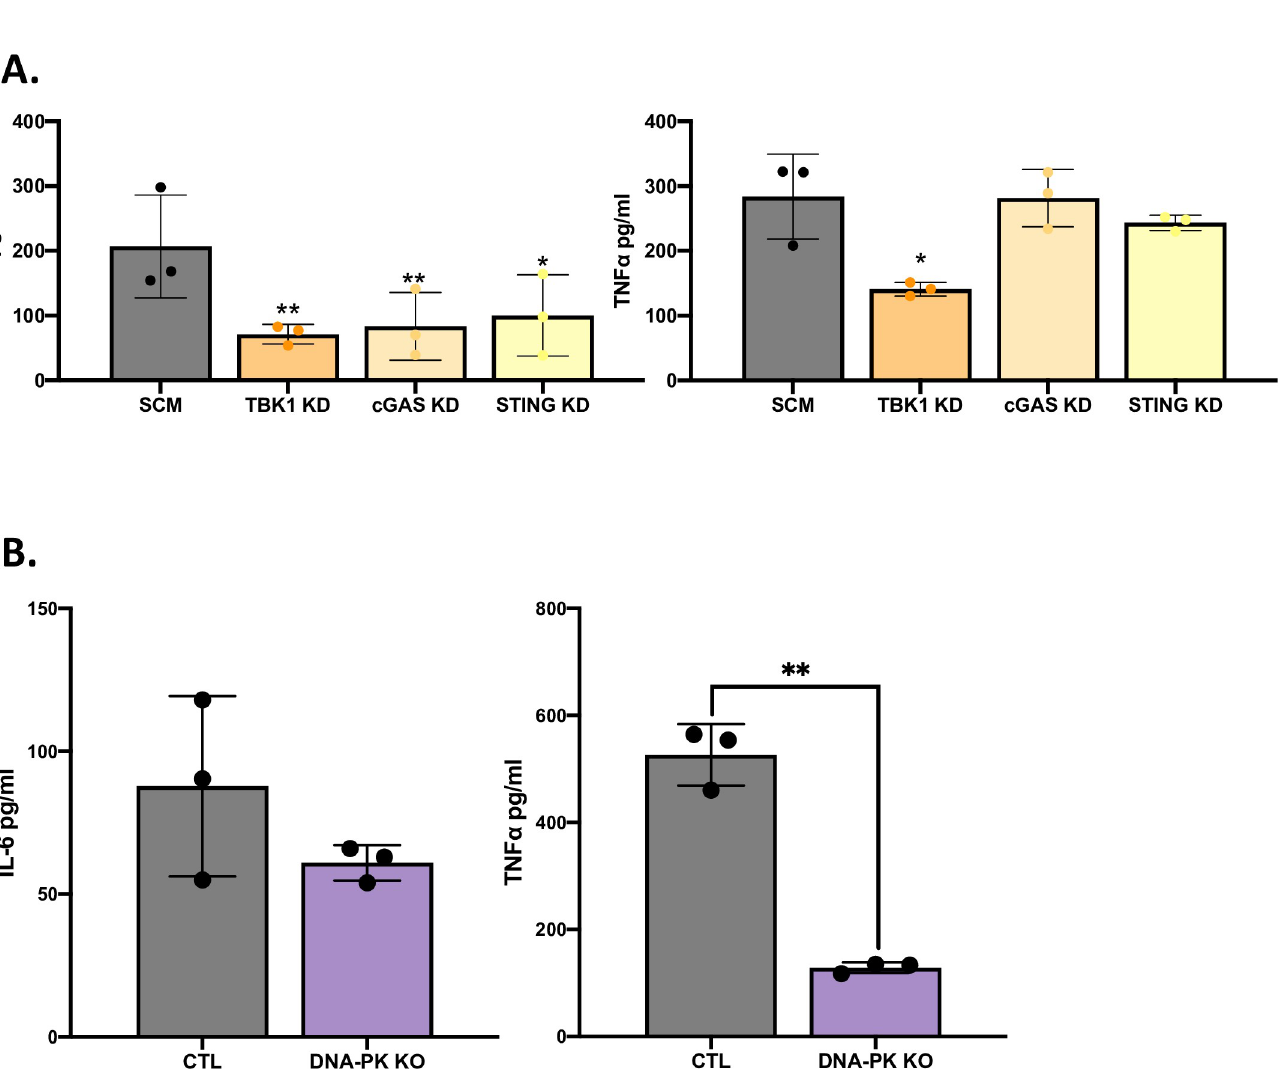
Fig 8. Effect of KD and KO of other nucleic acid-sensing pathways on cytokine production from human macrophages after infection with L . pneumophila . (A) U937 cell macrophages containing either an shRNA targeting TBK1 (TBK1 KD), cGAS (cGAS KD), or STING (STING KD) or a non-targeting scramble shRNA (SCM) were infected with strain 130b at a MOI of 20, and the levels of IL-6 (left panel) and TNF α (right panel) in culture supernatants at 9 h post infection were then determined by single-cytokine ELISA. The cytokine levels (pg/ml) were calculated relative to serial dilution of recombinant cytokine controls. (B) U937 cells expressing a non-targeting CRISPR guide plasmid (CTL, black bars) and U937 cells containing a CRISPR/Cas9-generated mutation in DNA-PK (purple bars) were infected with strain 130b for 9 h following a MOI of 20 and the levels of IL-6 (left) and TNF α (right) in culture supernatants were ascertained by ELISA. The cytokine levels (pg/ml) were calculated relative to serial dilution of recombinant cytokine controls. The graphs show the average cytokine levels ( n = 3 ) pooled from three independent experiments, each done in technical triplicate, with standard errors. Asterisks indicate points at which the values for samples from KD or KO cells were significantly different from those for samples from SCM or CTL cells ( � P < 0.05, �� P < 0.01, by Student’s t